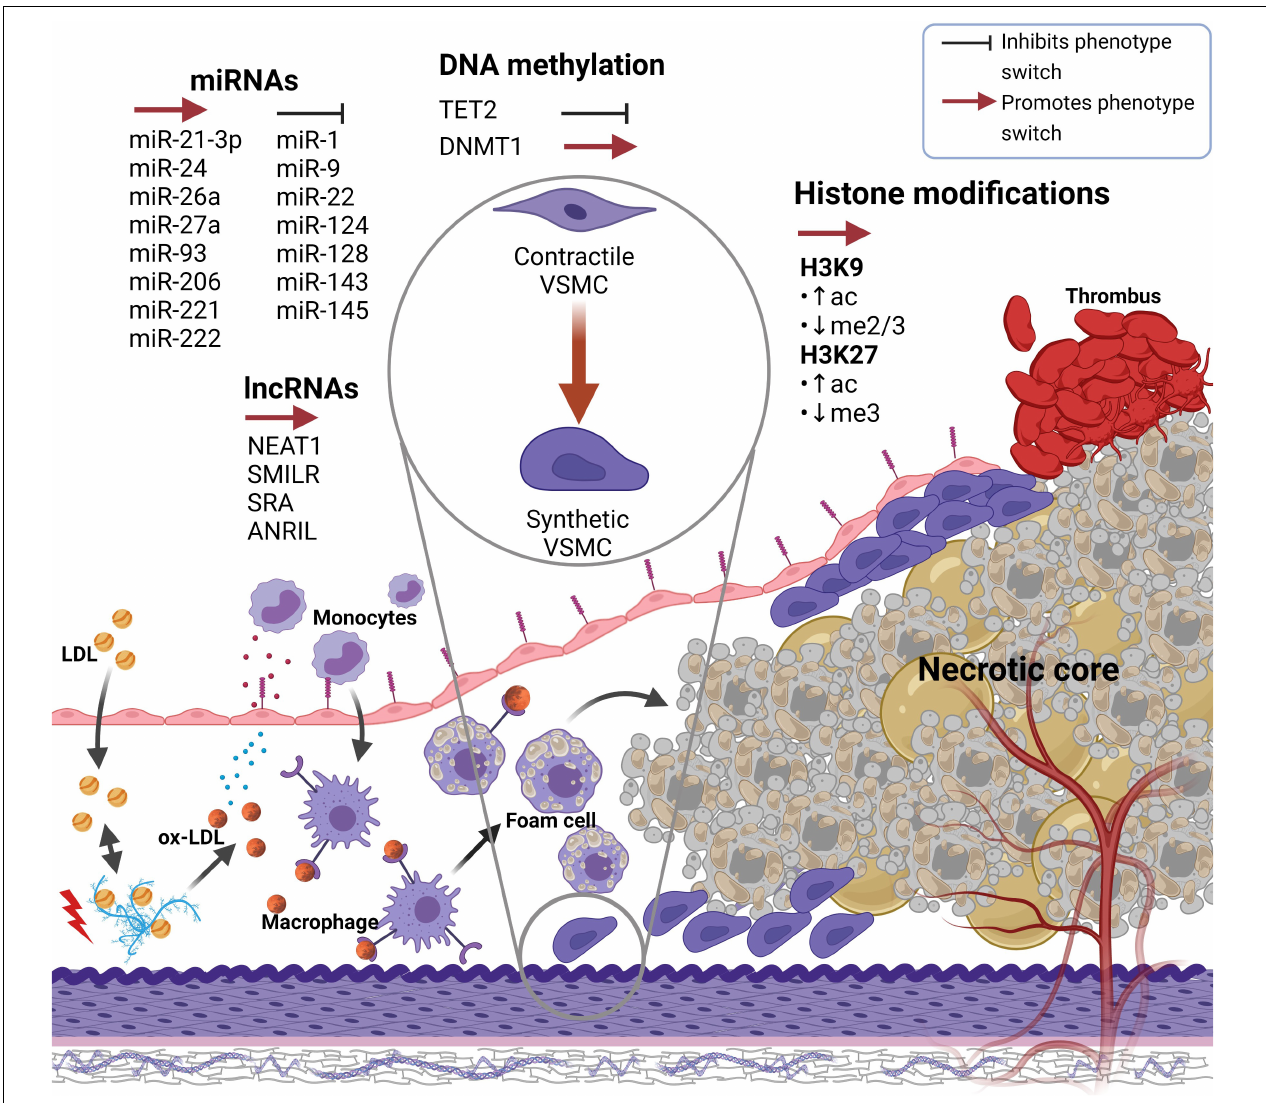
FIGURE 1 | Epigenetic factors either promoting or preventing VSMC phenotype switch in atherosclerotic artery remodeling. Atherosclerosis is initiated when LDL particles accumulate within the subendothelial space where they get oxidized, subsequently causing monocyte extravasation. Monocytes differentiate into macrophages which take up ox-LDL particles and gradually transform into foam cells that undergo cell death and create a necrotic lipid core within the intima. At a specific point in time, plaque rupture and thrombus forming may occur. During atherogenesis, various (epigenetic) factors trigger VSMCs, which reside within the tunica media, to switch from a contractile to a synthetic phenotype. Synthetic VSMCs migrate toward the intima where their proliferate and synthetize extracellular matrix components, resulting in neointima formation and thus arterial remodeling. Created with Biorender.com. VSMC(s), Vascular smooth muscle cell(s); LDL, Low-density lipoprotein; ox-LDL, Oxidized